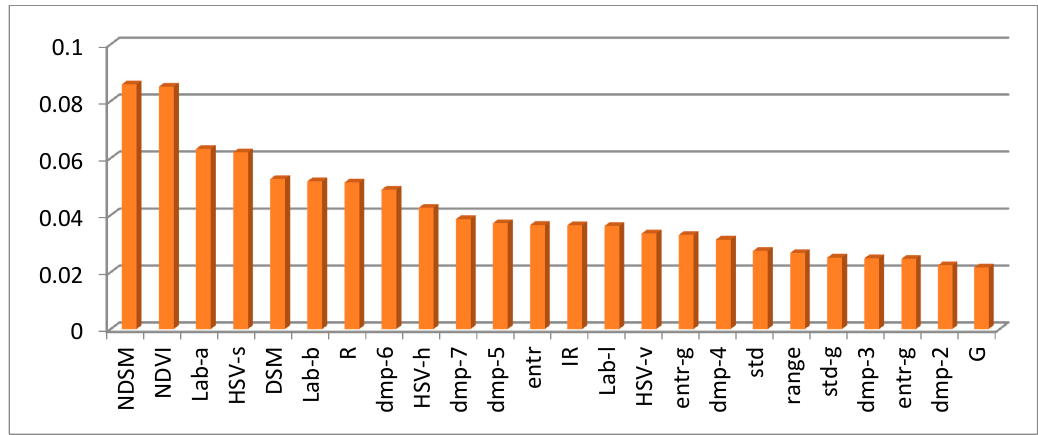
Figure 11. Feature importance indicator for classification, in descending order.